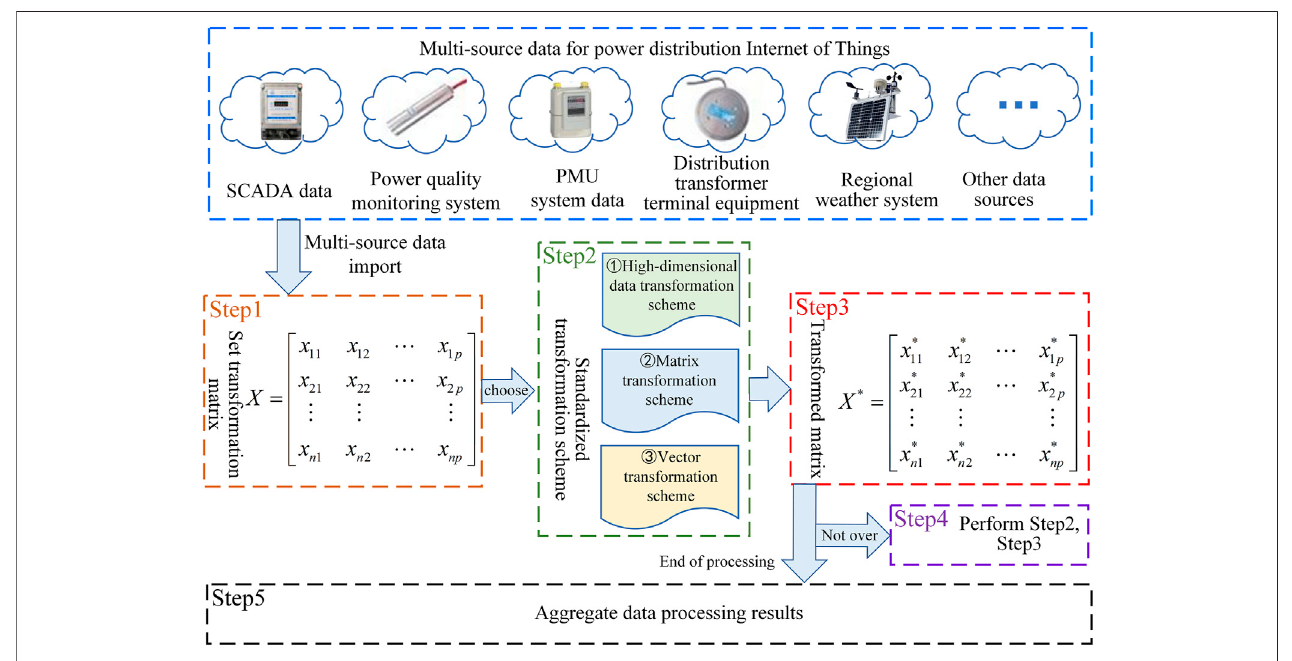
FIGURE 2 | Multi-source data standardization